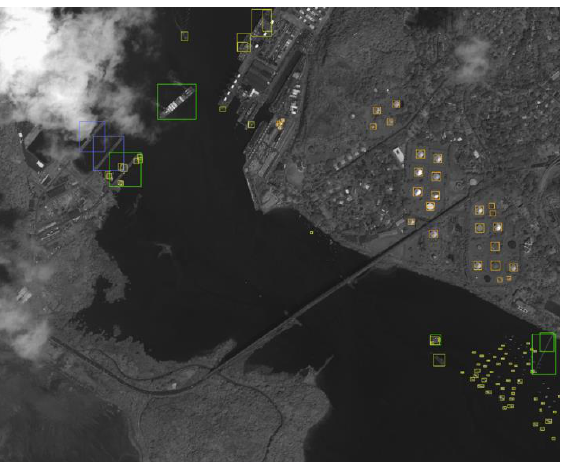
Figure 15. The detection performance of scene of river in the DOTA set, where yellow boxes repre- sent detected ships, green boxes represent detected harbors, orange boxes represent detected stor- age tanks and blue boxes represent detected bridges.